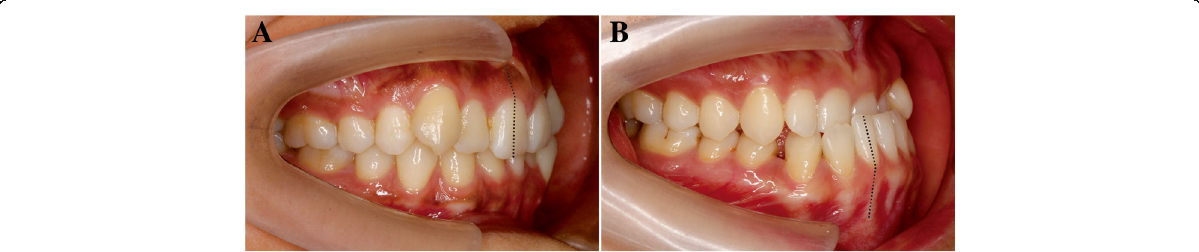
Fig. 1 a , b The inclination of the root and crown in maxillary and mandibular incisors are inconsistent with each other in the surface view, which indicates the crown-root angulation